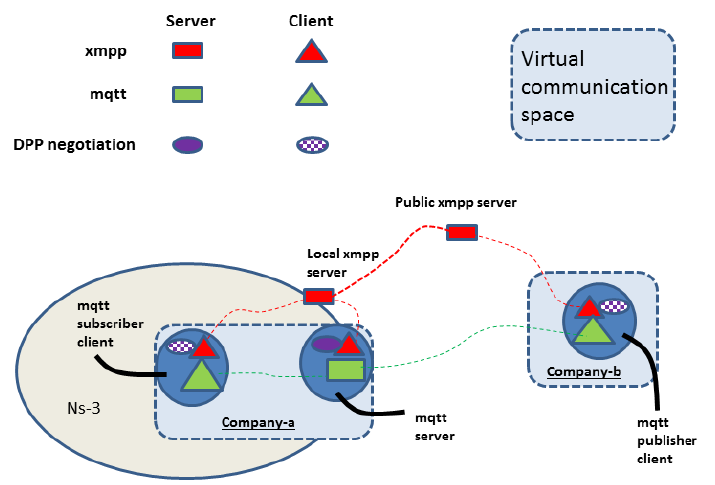
Figure 22. Data plane negotiation in the message queue based telemetry transport (MQTT) case.